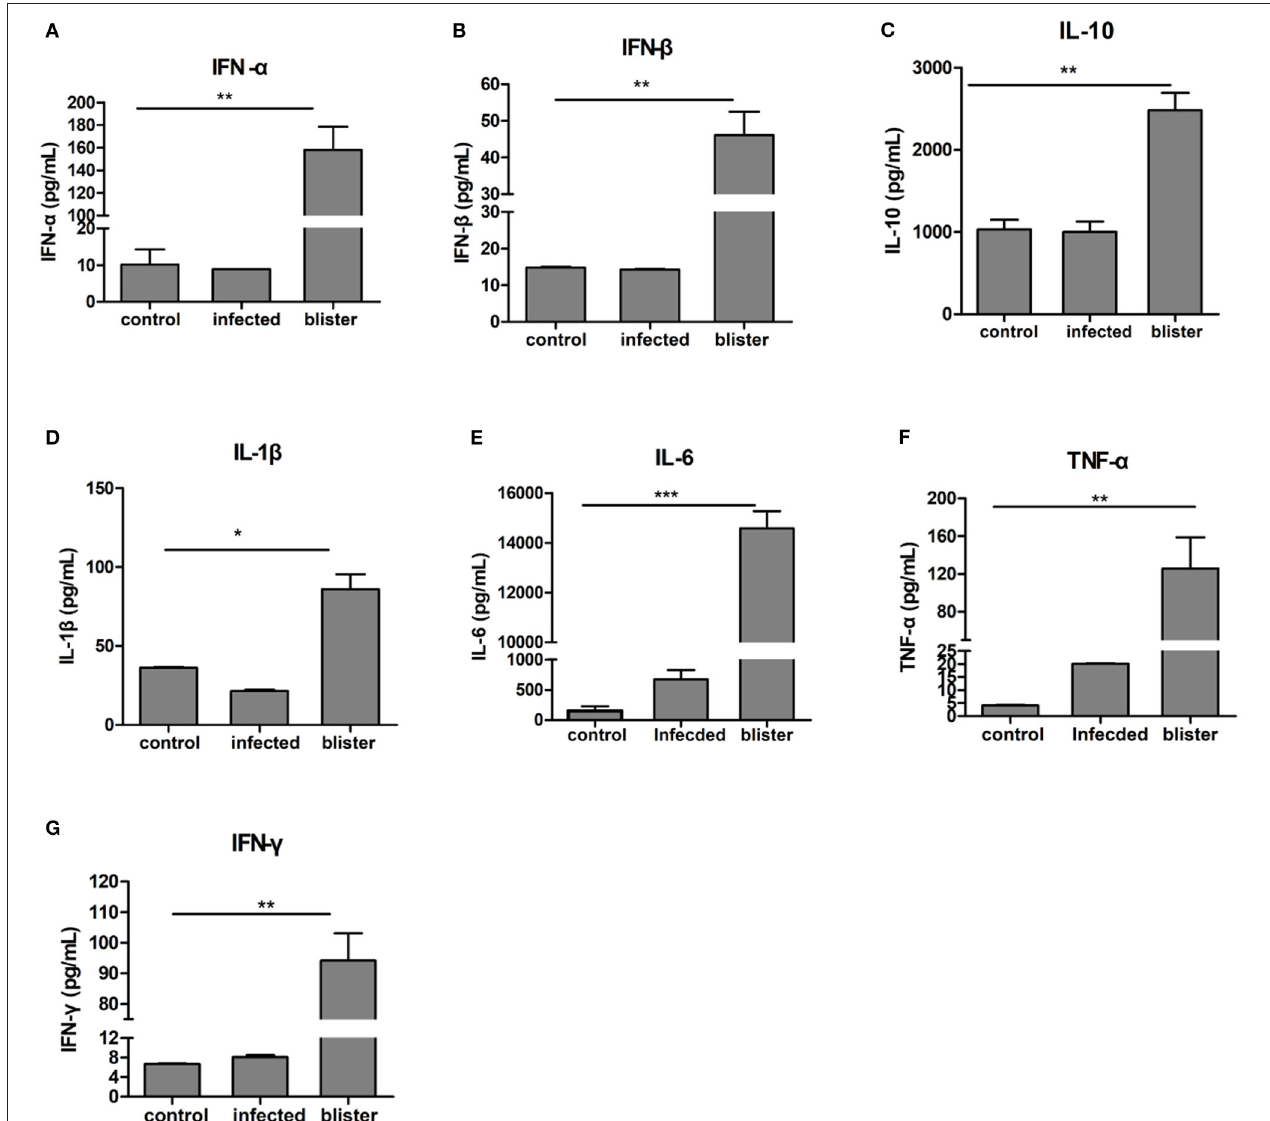
FIGURE 4 | Differential expression of cytokines in the vesicular fluid. After centrifuging the aspirated vesicular fluid, the supernatant and healthy pig serum were absorbed, diluted 10 times using the standard of ELISA kit, and the absorbance value was obtained at 450nm in strict accordance with the manufacturer’s instructions; then the cytokine content was calculated. (A,B) ELISA, determination of the expression of type I interferon; (C–F) ELISA, determination of the expression of inflammatory cytokines in the vesicular fluid; (G) ELISA, determination of the expression of IFN- γ . T-test was used to calculate the significant difference, which is marked as * P < 0.05,** P < 0.01,*** P < 0.001 in the